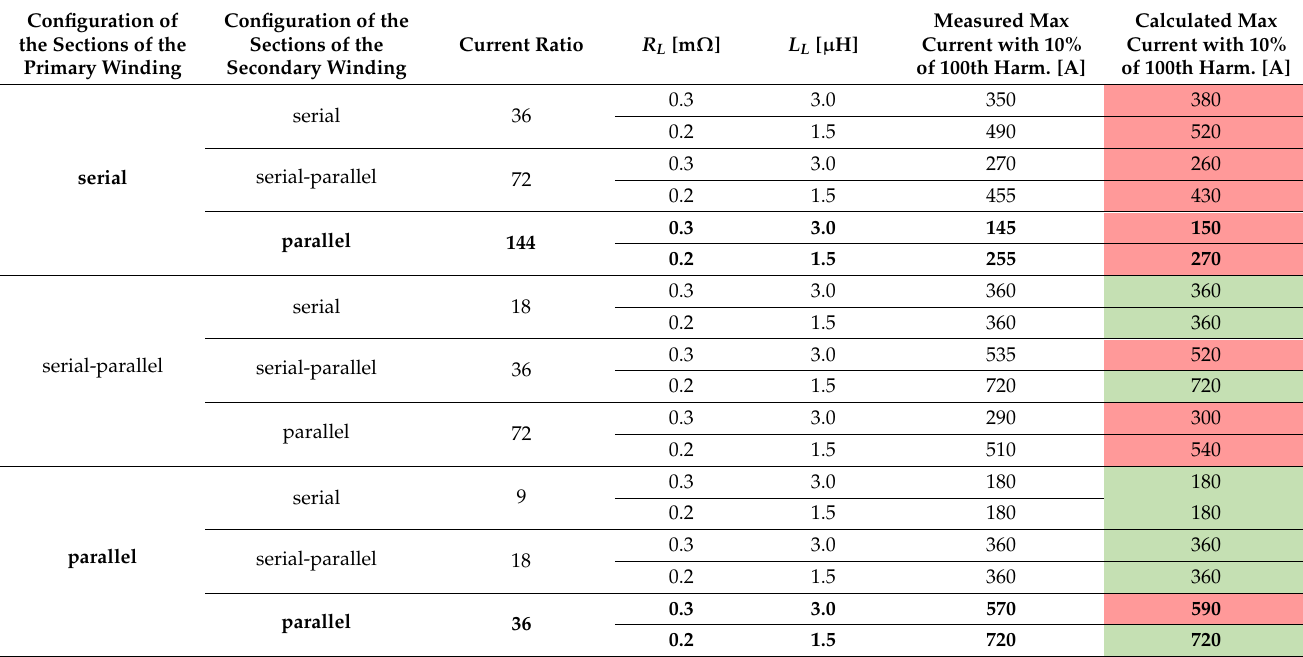
Table 1. Overview of the measured and calculated maximum values of the secondary current with the 100th order of higher harmonic equal to a 10% value of the main